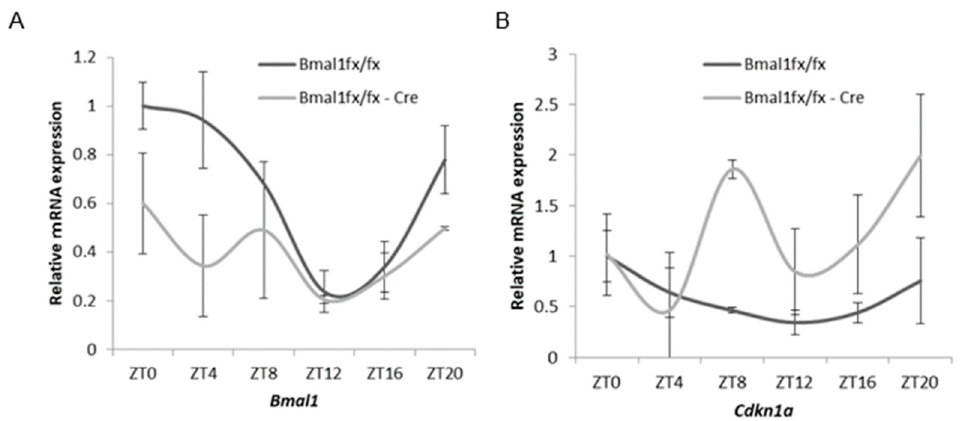
Figure 4. Oscillation of clock gene and Cdkn1a expression in mouse prostates detailing the temporal mRNA accumulation of Bmal1 and Cdkn1a in the dorsolateral mouse prostate under light–dark conditions ( N = 3 for each time point). ( A ) Bmal1 . ( B ) Cdkn1a . p -values with cosinor analysis in Bmal1 and Cdkn1a were 0.002 and 0.009 in Bmal1 lx/lx mice and 0.296 and 0.026 in pBmal1 KO mice, respectively.